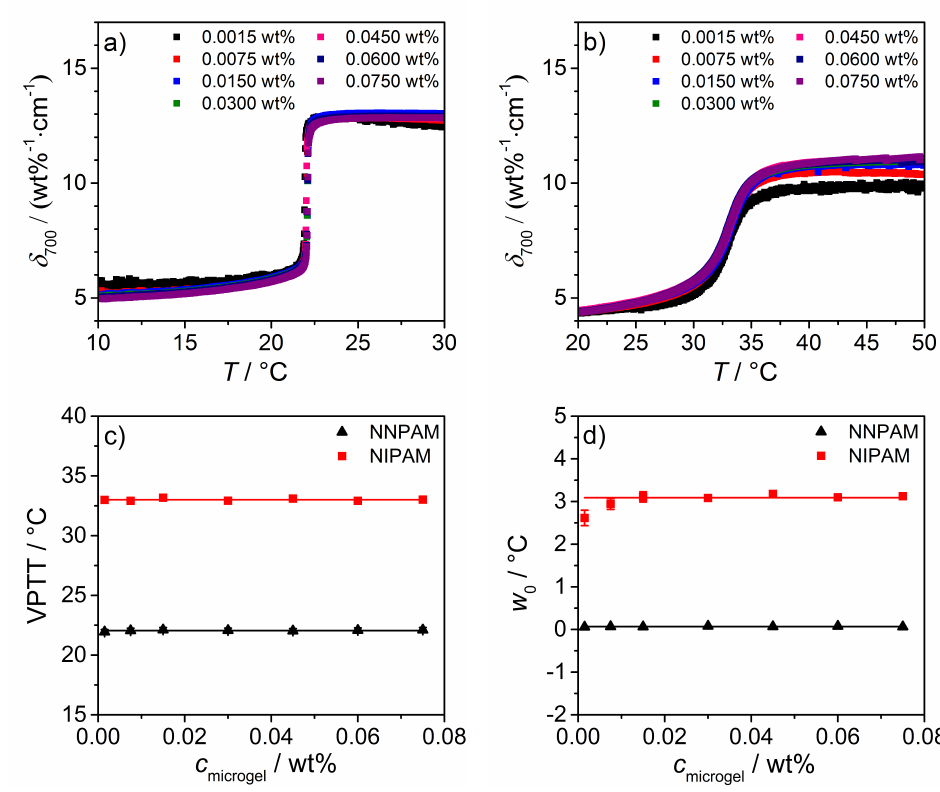
Figure 11. Normalized light attenuation coefficients for PNNPAM ( a ) and PNIPAM ( b ) microgels solutions with different concentrations as a function of temperature ( λ = 700nm). In graphs ( c ) and ( d ), a summary of the VPTTs and the w 0 -values for both microgels as a function of sample concentration is given. The solid lines correspond to the average value. It has to be mentioned that for PNIPAM the first w 0 -value (0.0015wt%) has been